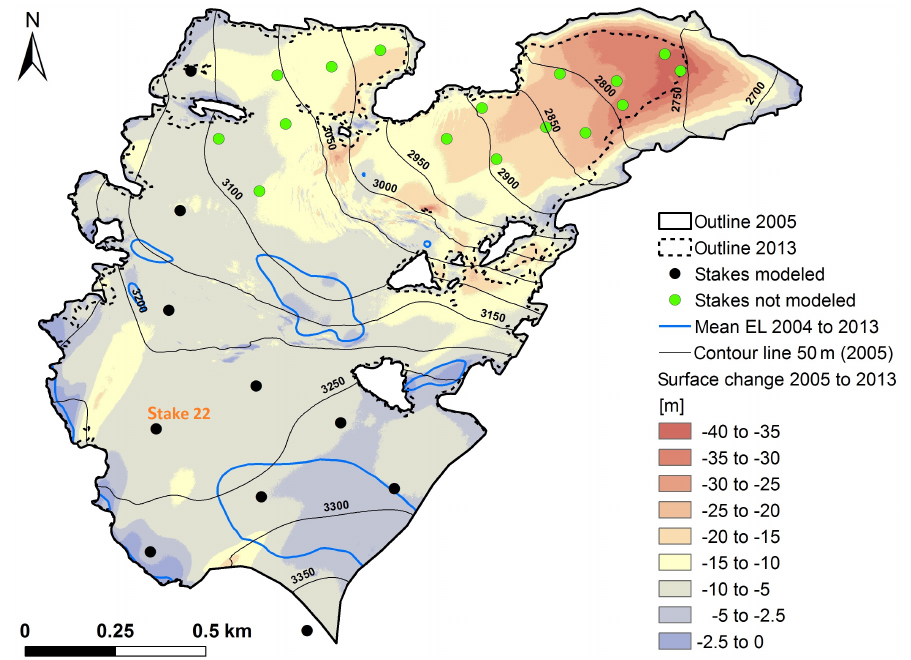
Figure 4. ALS-derived surface elevation change at Langenferner for the period September 2005 to September 2013. Also shown are the stakes used for the automatic extrapolation schemes, where black dots refer to locations to which the mass balance model was applied. The blue line indicates the equilibrium line at the end of the hydrological years averaged over the study period.